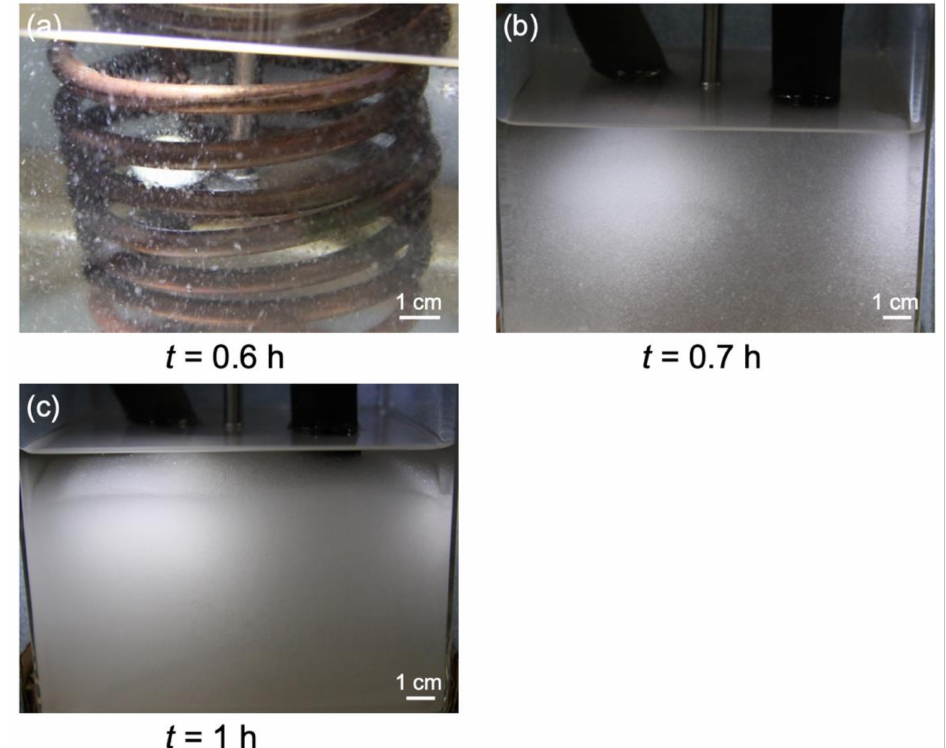
Figure 7. Optical observation changing in the container with mechanical agitation of 300 rpm. ( a – c ) are the pictures at 0.6 h, 0.7 h and 1 h after cooling water started to be circulated,